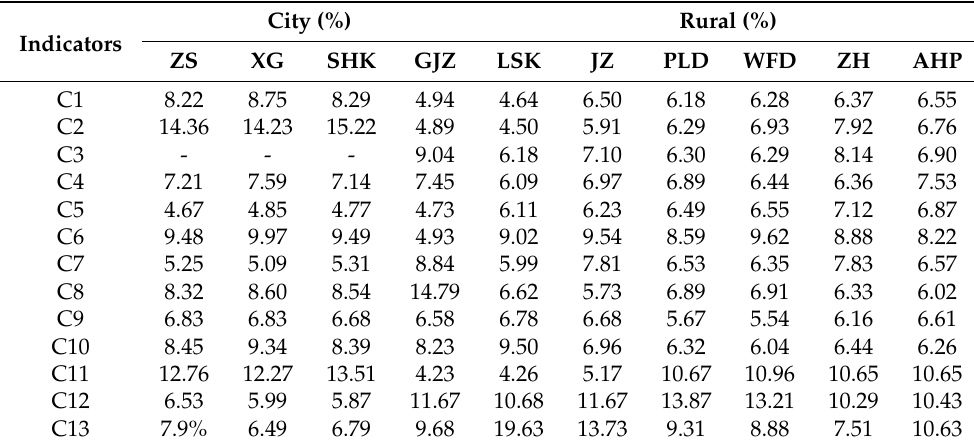
Table 3. Comprehensive weight of each